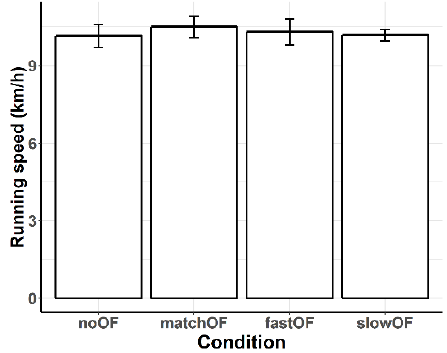
Figure 2. Running speed selected as matching the reference running speed in different optical flow conditions. The bars represent the means and the error bars the 95% confidence interval of those means.